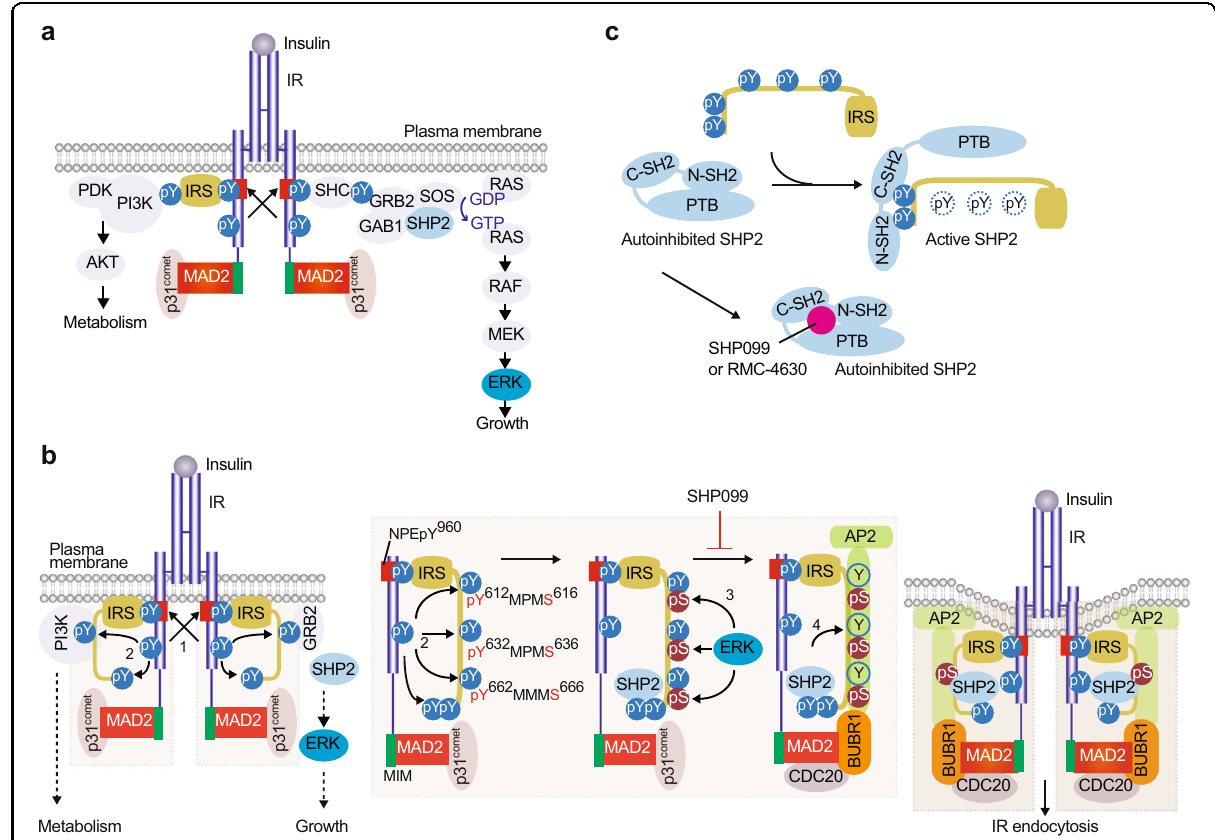
Fig. 1 IRS- and MAD2-dependent mechanisms collaborate to trigger IR endocytosis. a The insulin receptor signaling pathway. b Model of the regulation of IR endocytosis by IRS and spindle checkpoint proteins. In the basal state, p31 comet prevents IR endocytosis. Activated IR auto- phosphorylates multiple tyrosine residues on IR, including Y960 in the NPEY 960 motif (1), recruits IRS proteins and initiates insulin signaling cascades. IR phosphorylates Y612/Y632/Y662 of the YXX Φ motifs on IRS1 (2). Activated ERK phosphorylates S616/S636/S666 on IRS1 (3). SHP2 binds to the C- terminal phosphotyrosine sites on IRS1 and dephosphorylates pY612/pY632/pY662 of the doubly phosphorylated IRS1 (pY/pS) to facilitate the IRS1 – AP2 interaction (4). IR-bound MAD2 binds to BUBR1-CDC20, providing another binding surface for AP2. These two modules promote IR endocytosis. Inhibition of the feedback regulation prevents IR endocytosis, prolongs metabolic branch of insulin signaling, and improves insulin sensitivity. MIM, MAD2-interacting